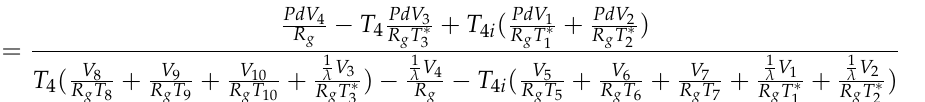
pletely the same as the Vuilleumier model with three chambers, except for the